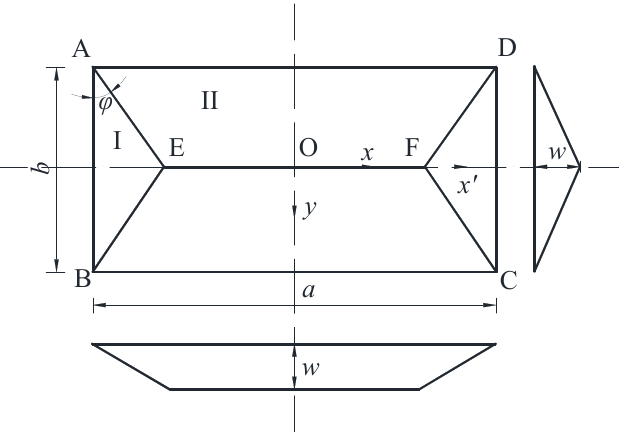
Figure 3. Assumed deformation of the entire structure. The four sides of the sandwich panel are rigidly fixed. Under the action of the explosion load, the deformed sandwich panel is divided into four rigid areas, namely two rigid areas I and two rigid areas II. There are plastic hinge lines between each rigid region and between each rigid region and the boundary. At the same time, it is considered that the deformation mode does not change with time during the deformation process of the sandwich panel. It can be seen from Figure 3 that for the fully clamped metal sandwich structure, the plastic deformation only occurs at the plastic hinge. The other parts of the structure are considered ideally rigid and are divided into four regions, named Region I and Region II, respectively, which are in different directions. To describe the deformation of the structure, the dimensionless factor ξ = b / a is defined as the aspect ratio of the